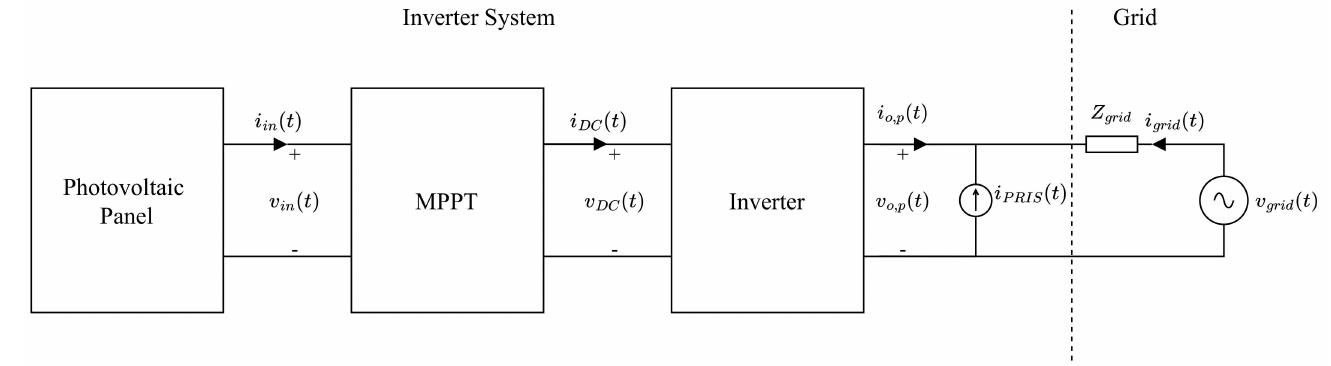
Figure 15. Block diagram of the inverter system during PRIS